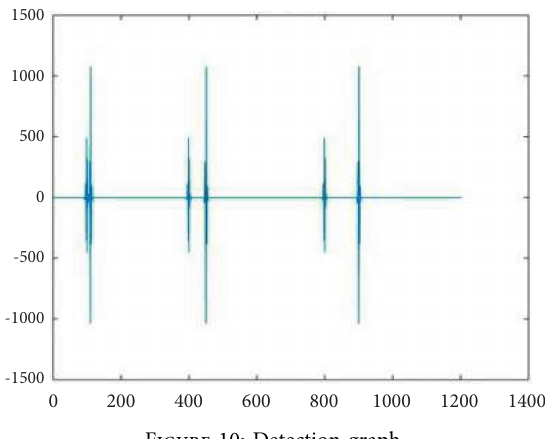
Figure 10: Detection